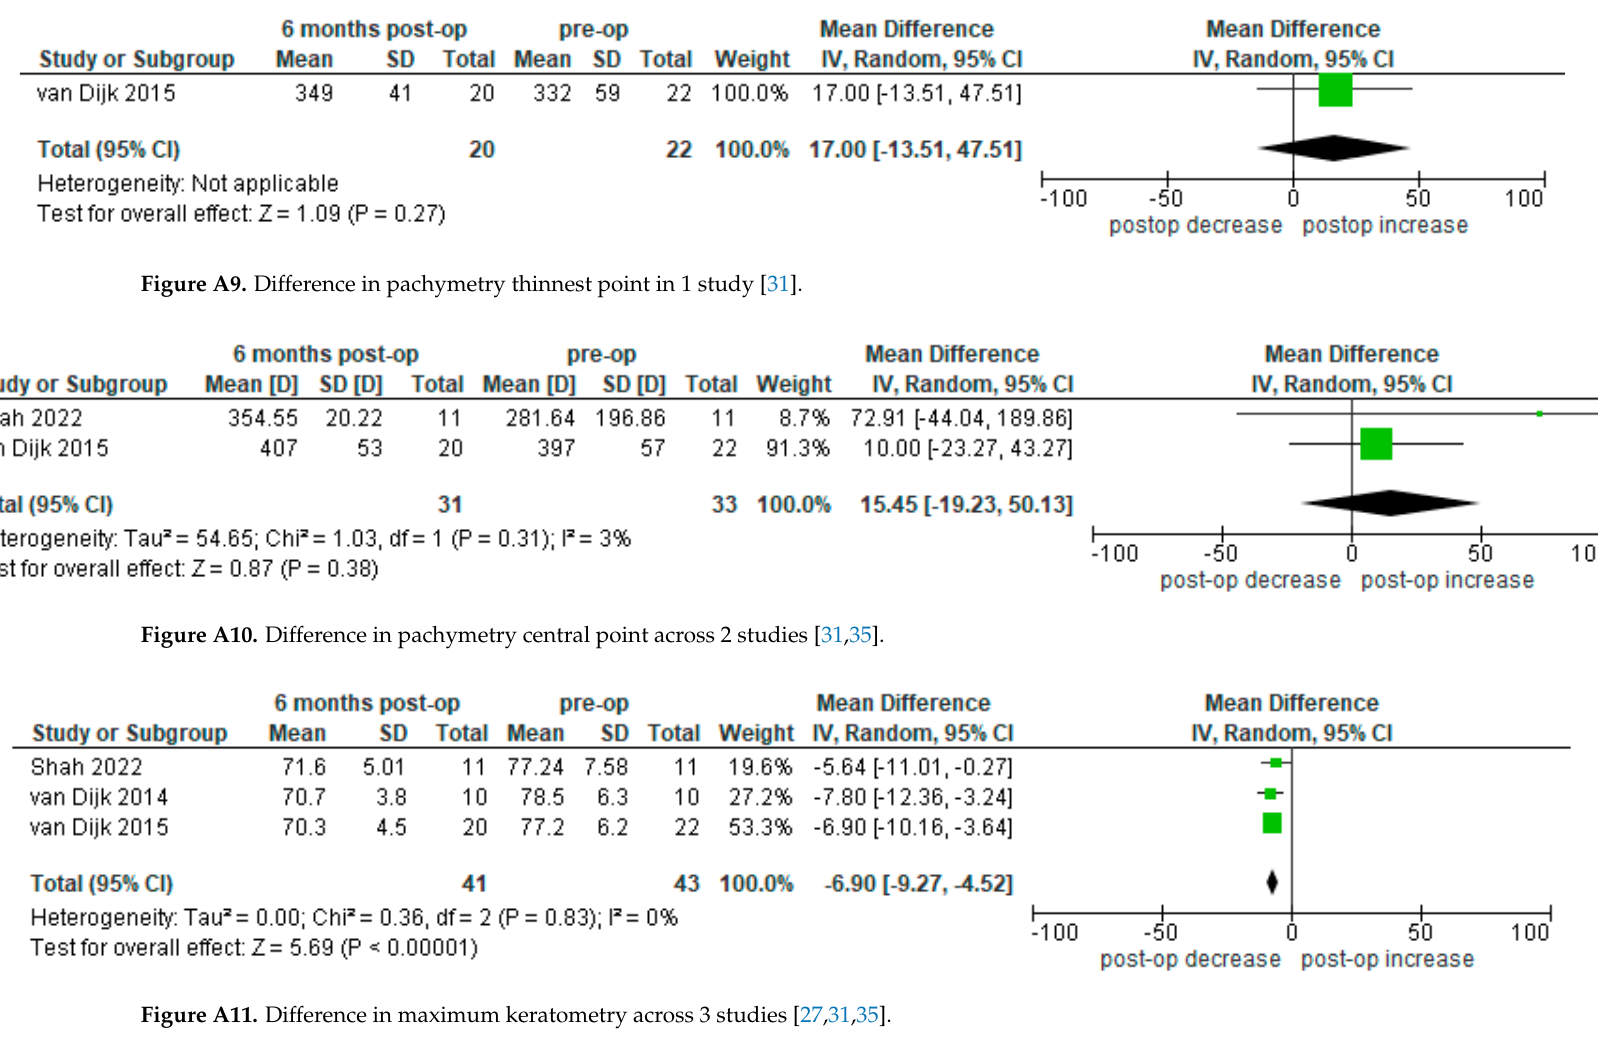
Figure A12. Di ff erence in mean simulated keratometry in 3 studies [27,31,35].